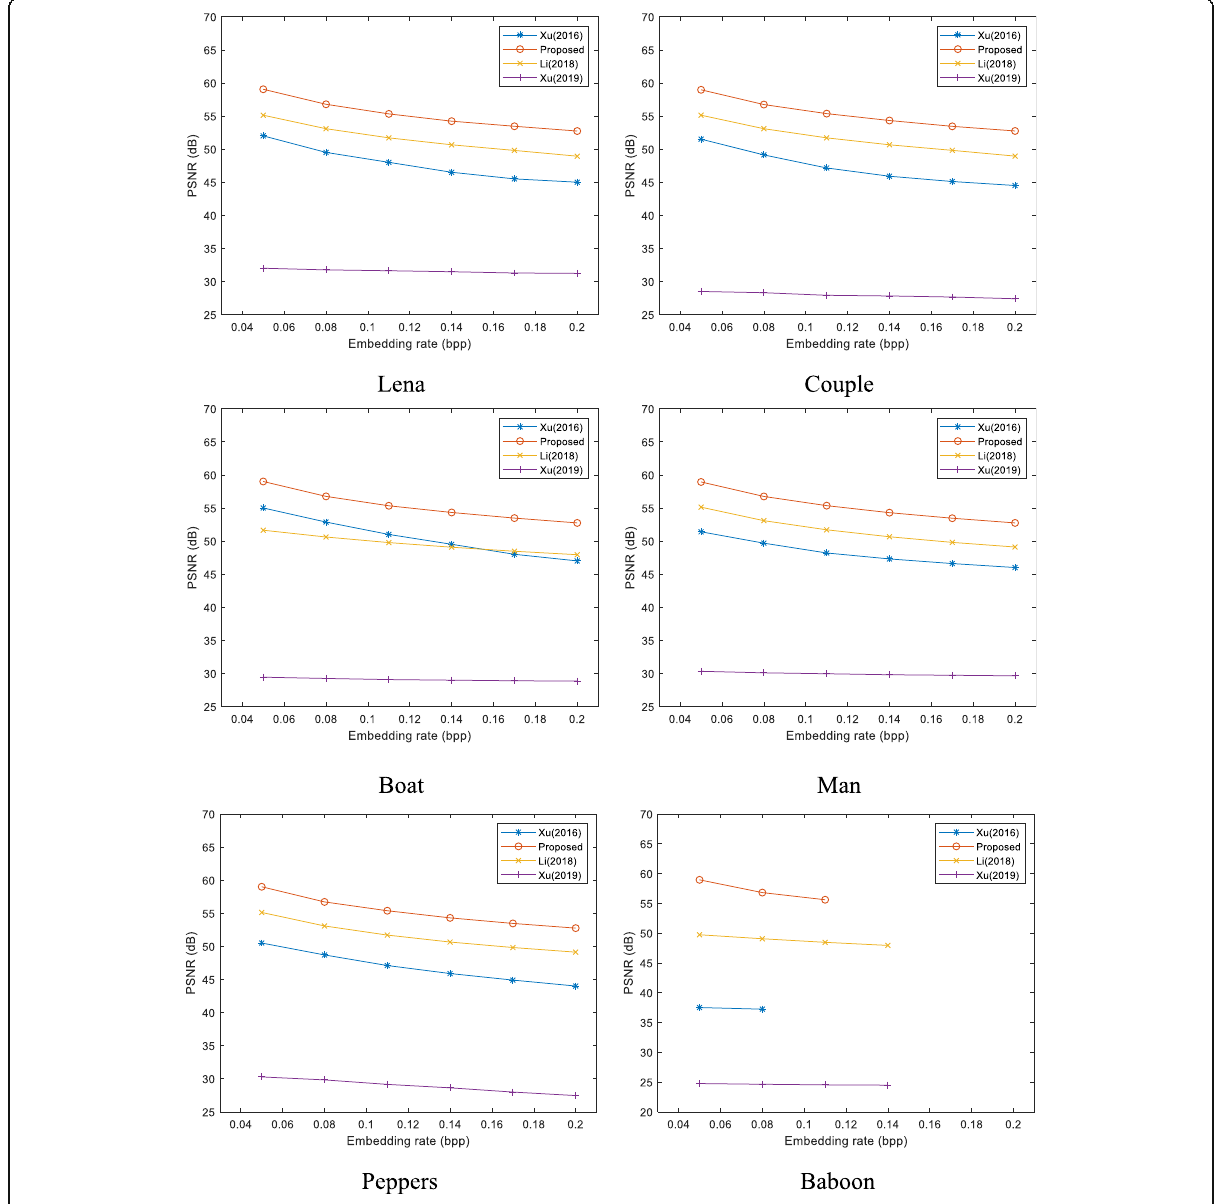
Fig. 11 Performance comparisons between the methods [18, 20, 33], and the proposed method in terms of ER versus